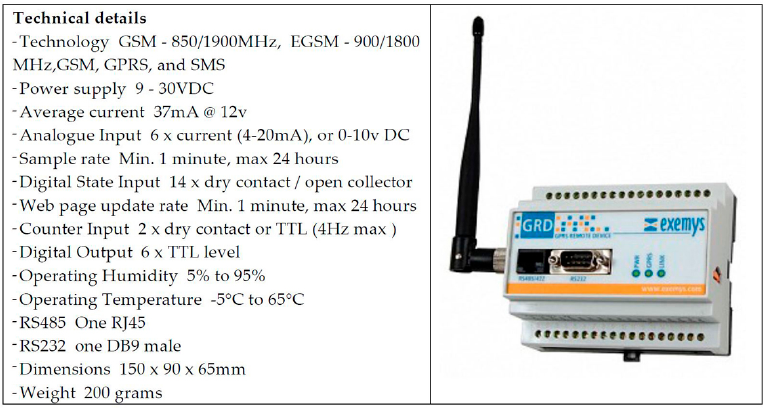
Figure 6. Technical file of the Data Logger.